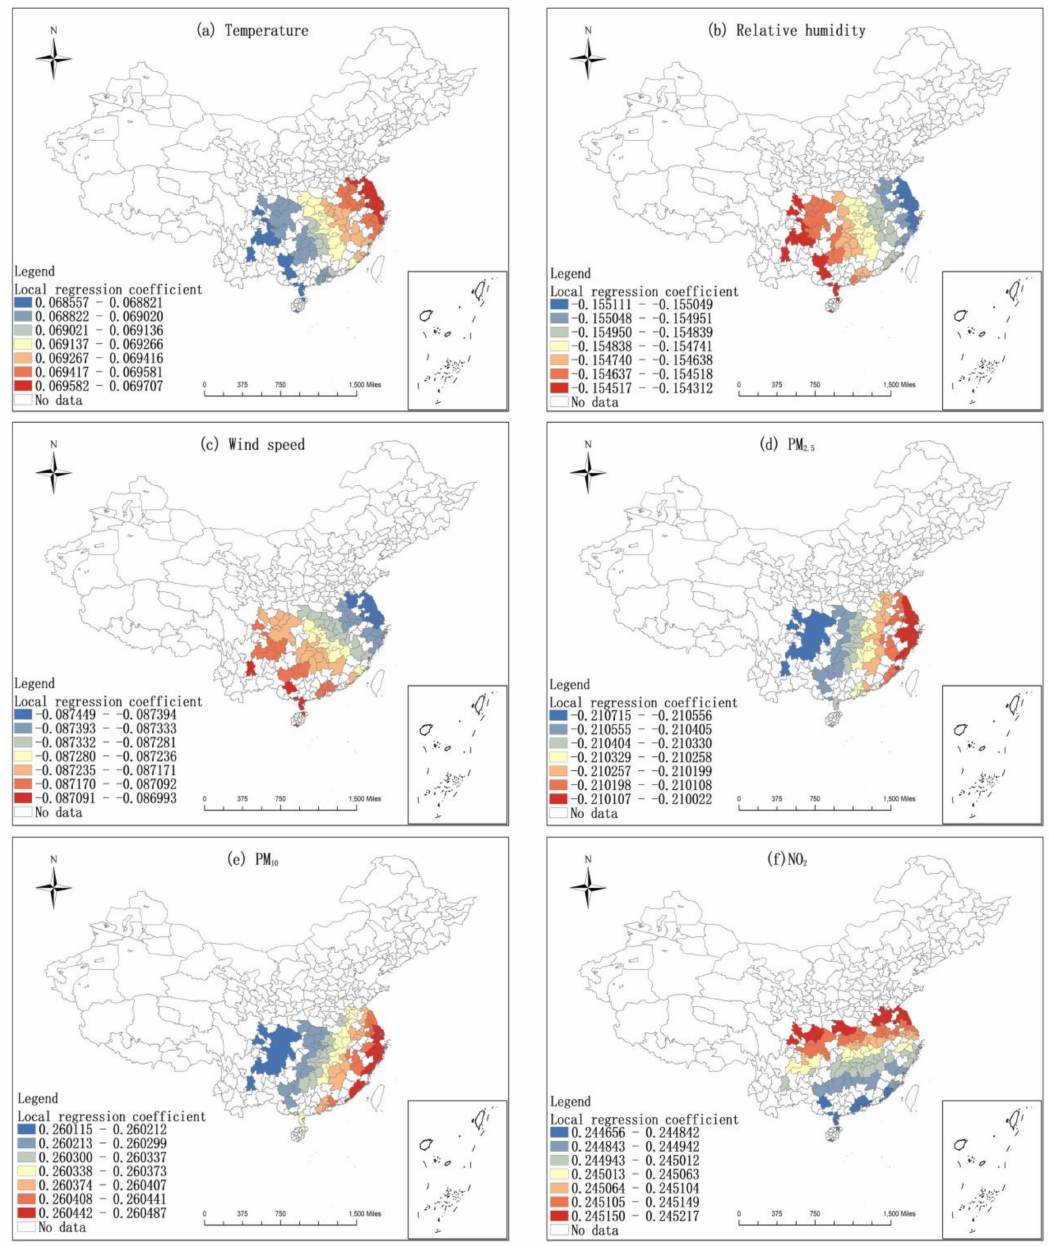
Figure 10. The local regression coefficient diagram of meteorological factors and air pollutants in southern